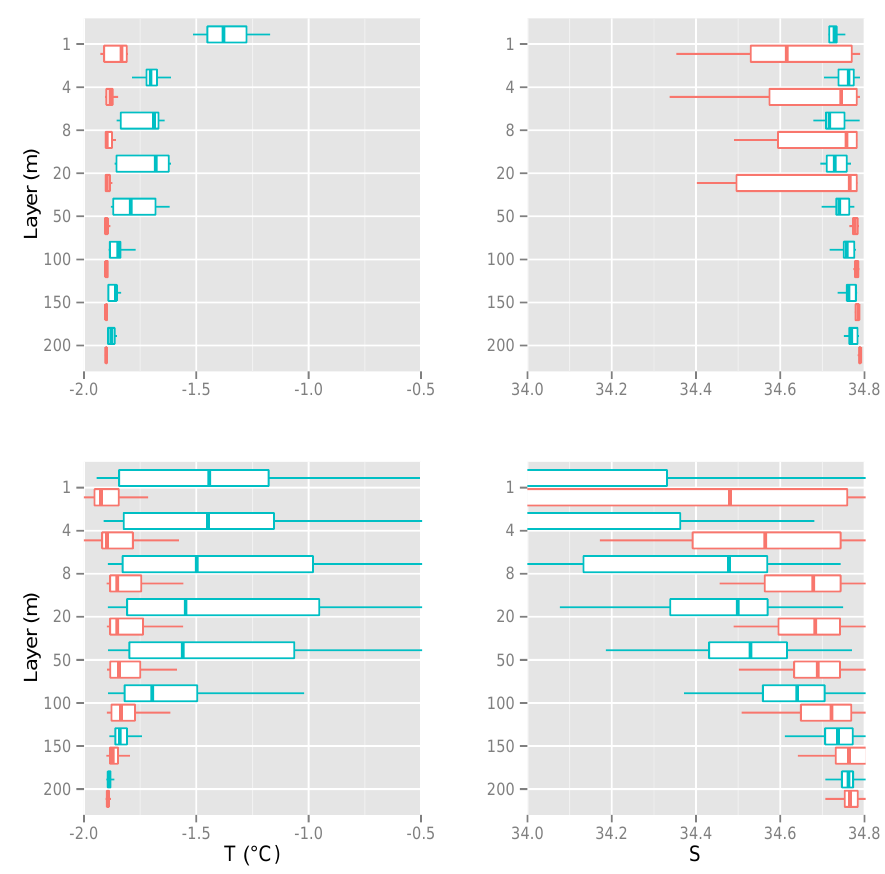
Figure 4. Upper panels: Field temperature ( left ) and salinity ( right ) measured at FRIDA station. Lower panels: Temperature ( left ) and salinity ( right ) modelled in the Terra Nova Bay area. Red boxes refer to the first half of November; green boxes refer to the second half of November.